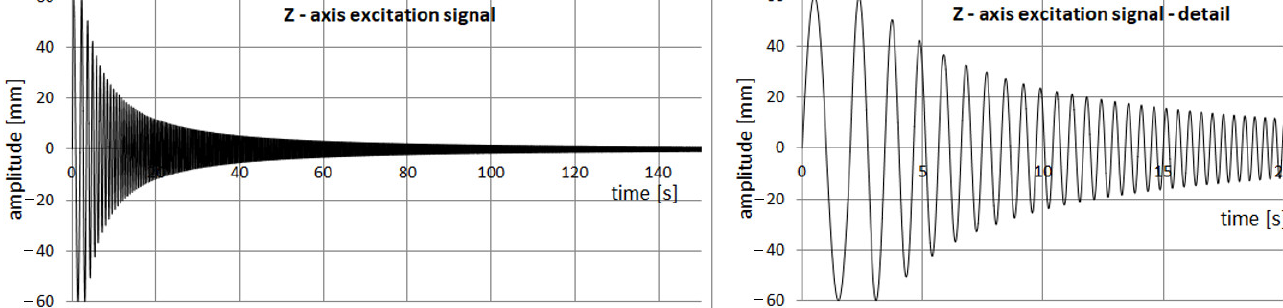
Figure 7. Test signal for Z-axis excitation.